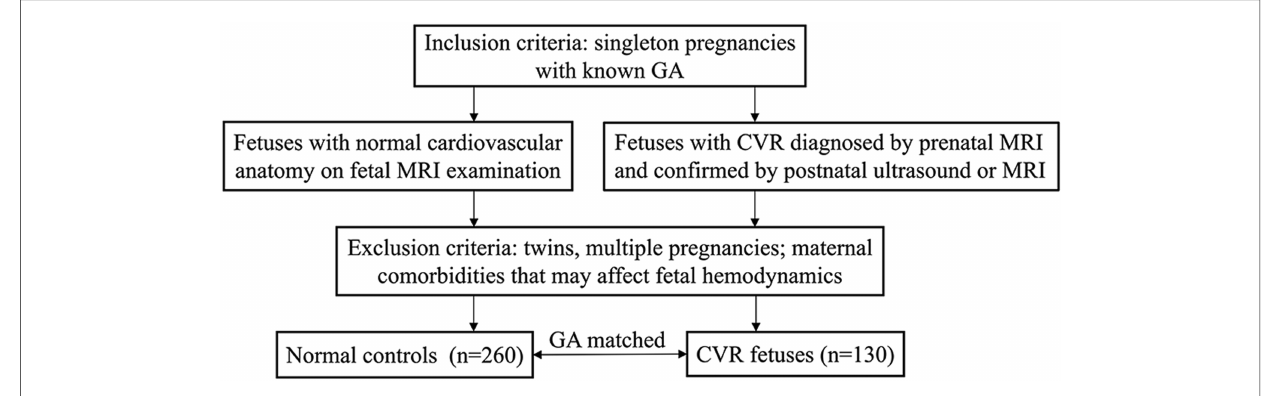
FIGURE 1 Flowchart showing the subjects inclusion and exclusion criteria. GA, gestational age; CVR, complete vascular ring; MRI, magnetic resonance imaging.